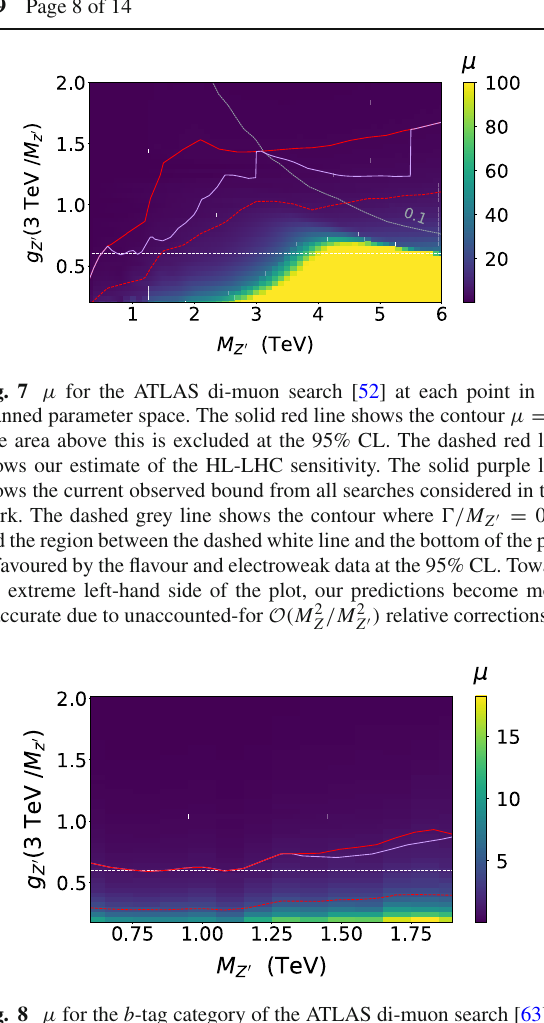
Fig. 10 μ fortheATLASdi-tau[66]searchateachpointinthescanned parameter space. The solid red line shows the contour μ = 1. The area above this is excluded at the 95% CL. The dashed red line shows our estimate of the HL-LHC sensitivity. The solid purple line shows the current observed bound from all searches considered in this work. The dashed grey line shows the contour where (cid:10)/ M Z (cid:2) = 0 . 1 , and the region between the dashed white line and the bottom of the plot is favoured by the flavour and electroweak data at the 95% CL. Toward the extreme / M 2 ) Z Z (cid:2) left-hand side of the plot, our predictions become more inaccurate due / M 2 ) relative corrections to unaccounted-for O ( M 2 Z Z (cid:2)